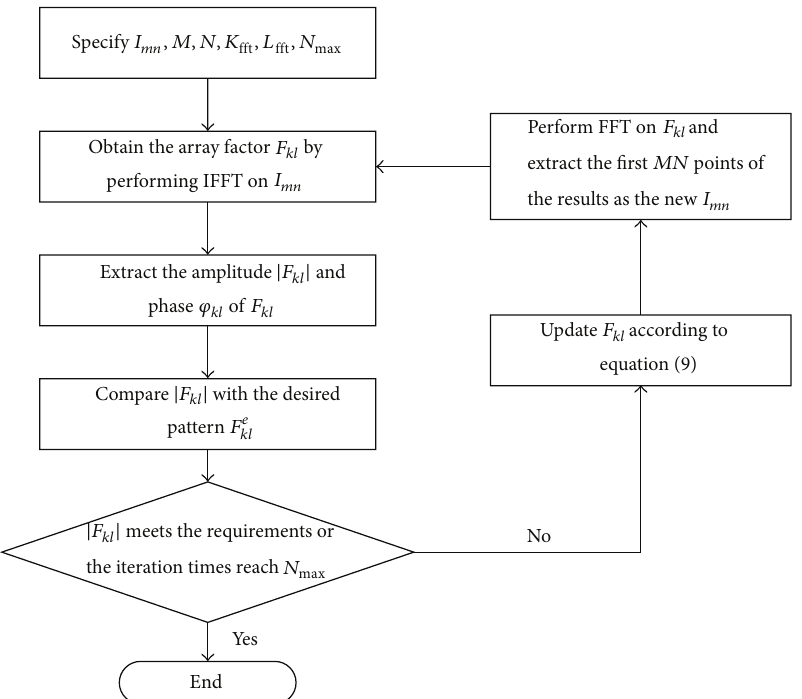
Figure 1: Flowchart of the FFT procedure for pattern